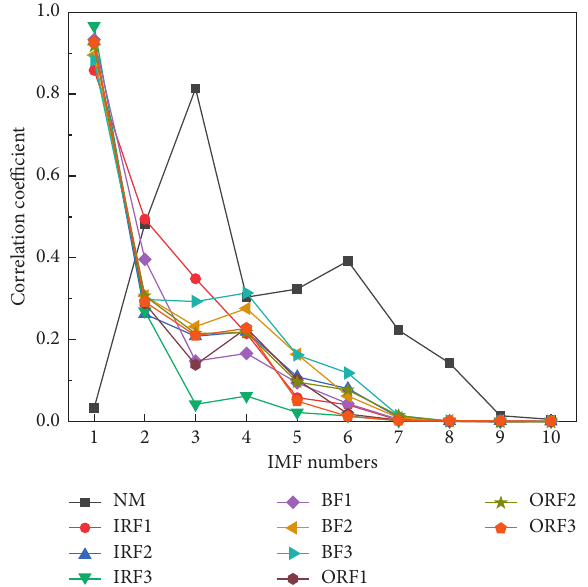
Figure 14: The error bar diagram of ImvMAAPE values in 20 scales under 10 working conditions of bearing